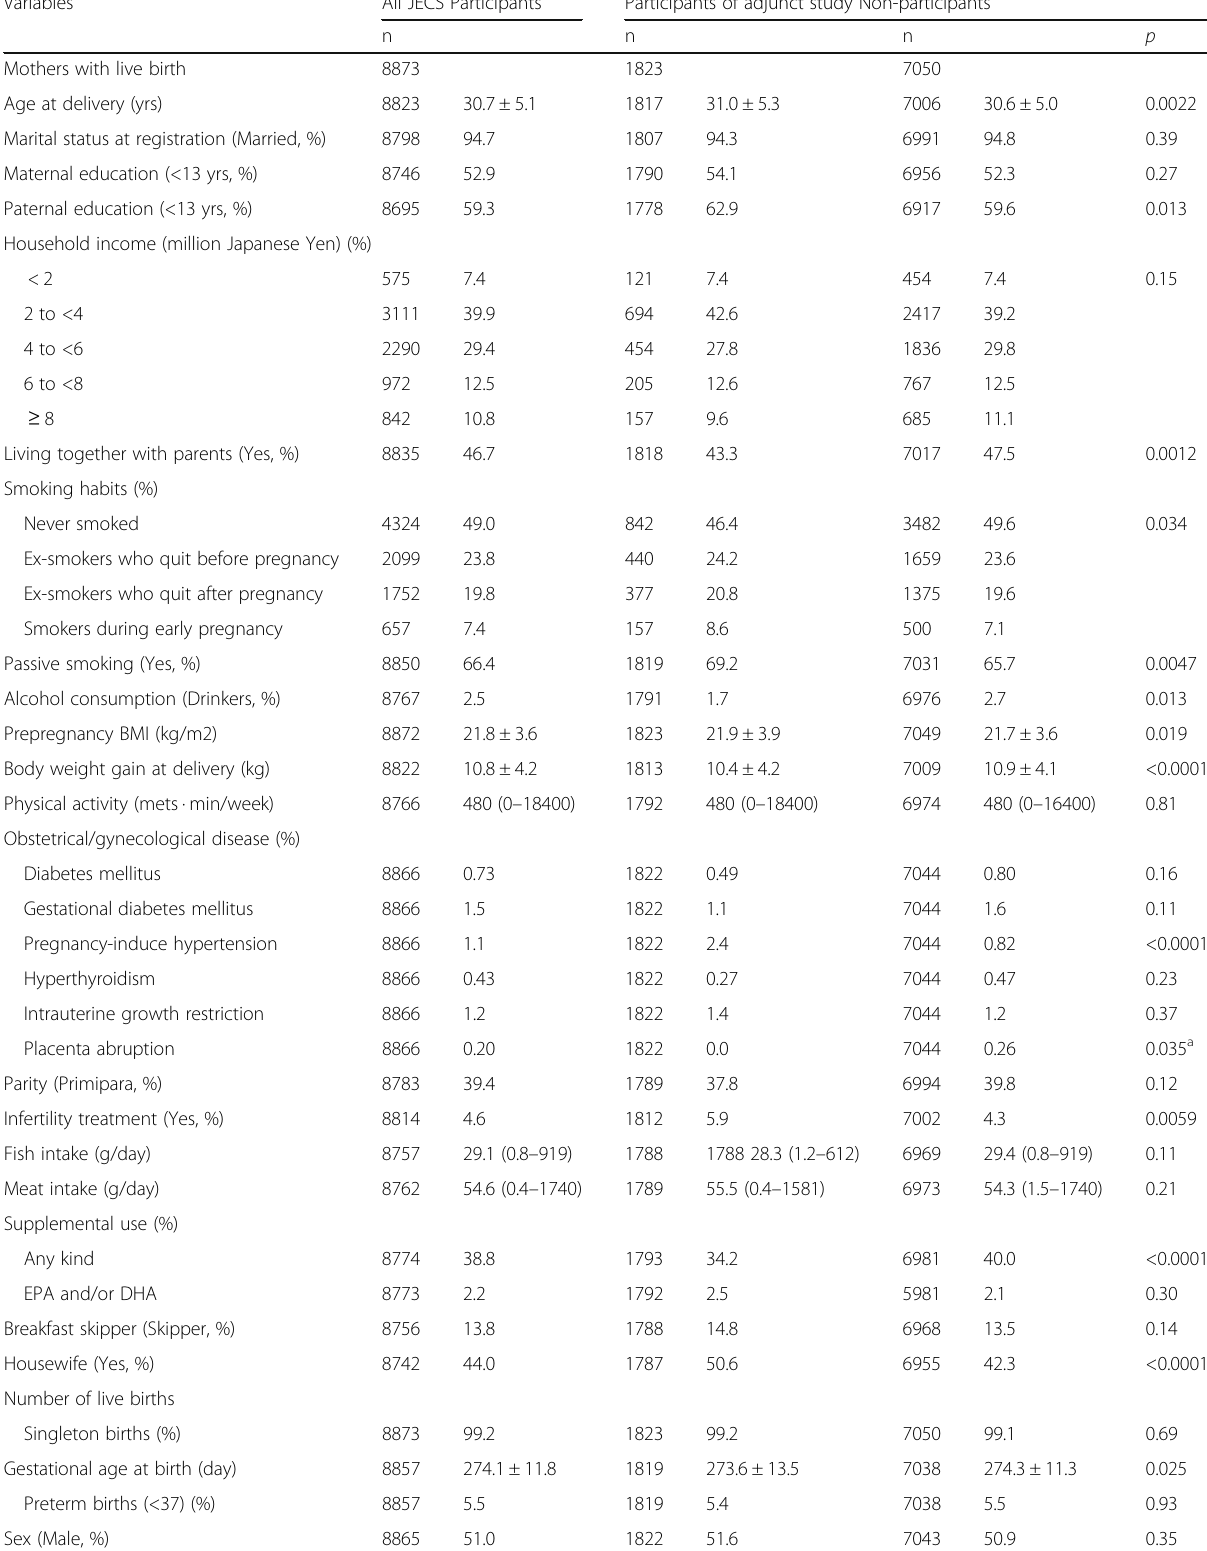
Table 1 Basic characteristics of the participants and the non-participants having live birth in the adjunct study of JECS Variables All JECS Participants Participants of adjunct study Non-participants n n n